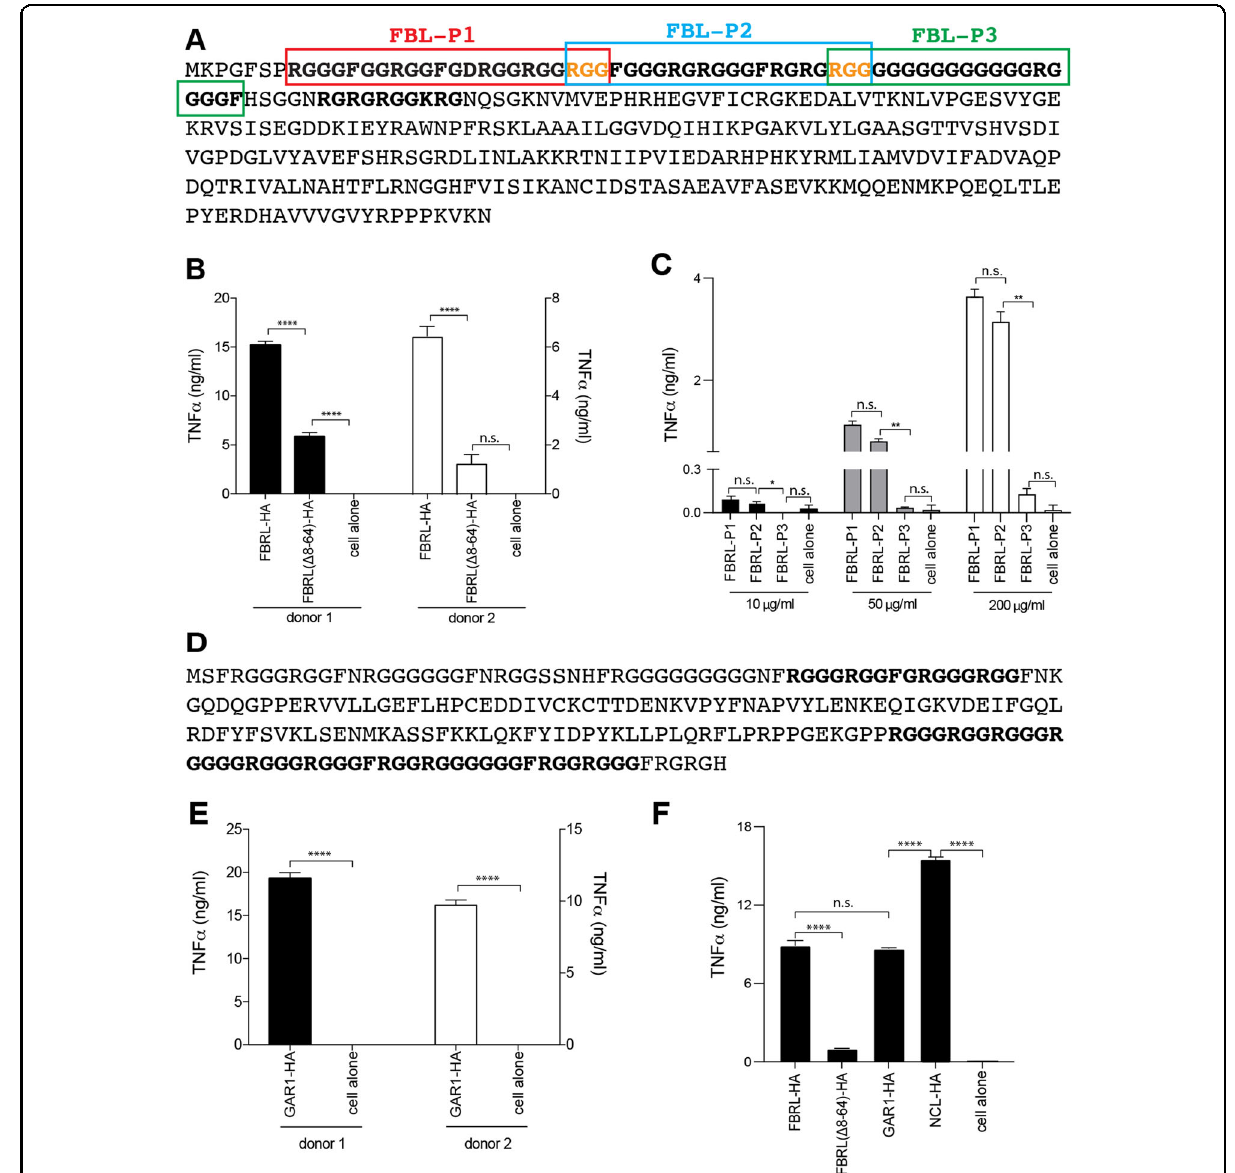
Fig. 5 Fibrillarin (FBRL) and GAR1 are nucleolar alarmins. A FBRL sequence showing a GAR/RGG and a GAR/RG motif. Three peptides were synthesized as indicated and overlapping residues were highlighted (orange font). The GAR/RGG motif was deleted to generate the FBRL( Δ 8-64)-HA mutant. B FBRL-HA and FBRL( Δ 8-64)-HA were puri fi ed and plate-coated (40 μ g/ml) to stimulate PBMC for 24 h and TNF α production was measured by ELISA. C PBMC were stimulated for 24 h with the FBRL peptides (10, 50, or 200 μ g/ml) and TNF α production was determined by ELISA. D GAR1 sequence showing two GAR/RGG motifs. E GAR1-HA (40 μ g/ml) was puri fi ed and coated to stimulate PBMC and TNF α production was determined by ELISA. F Comparison of FBRL, GAR1, and NCL in alarmin activities. The puri fi ed proteins were plate-coated (40 μ g/ml) to stimulate PBMC for 24 h. TNF α production was determined by ELISA. Cell controls, no stimulation. Triplicate experiments were performed to obtain data as mean ± SD. Data was analyzed by one-way ANOVA * p < 0.05, **** p < 0.0001, n.s., not signi fi